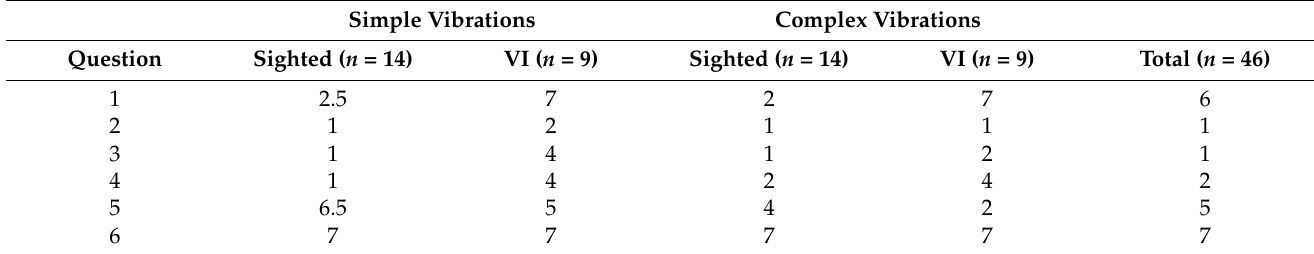
Table 6. Median results of the EXT application usability